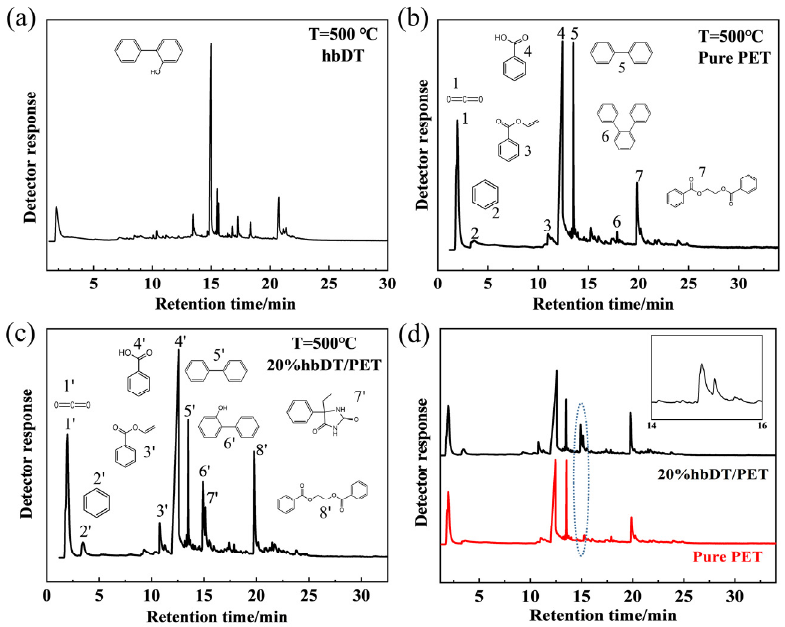
Figure 8. Ion chromatograms of ( a ) hbDT, ( b ) pure PET, ( c ) hbDT/PET, and ( d ) enlarged comparison chromatograms between pure PET and hbDT/PET in PY-GC/MS test.